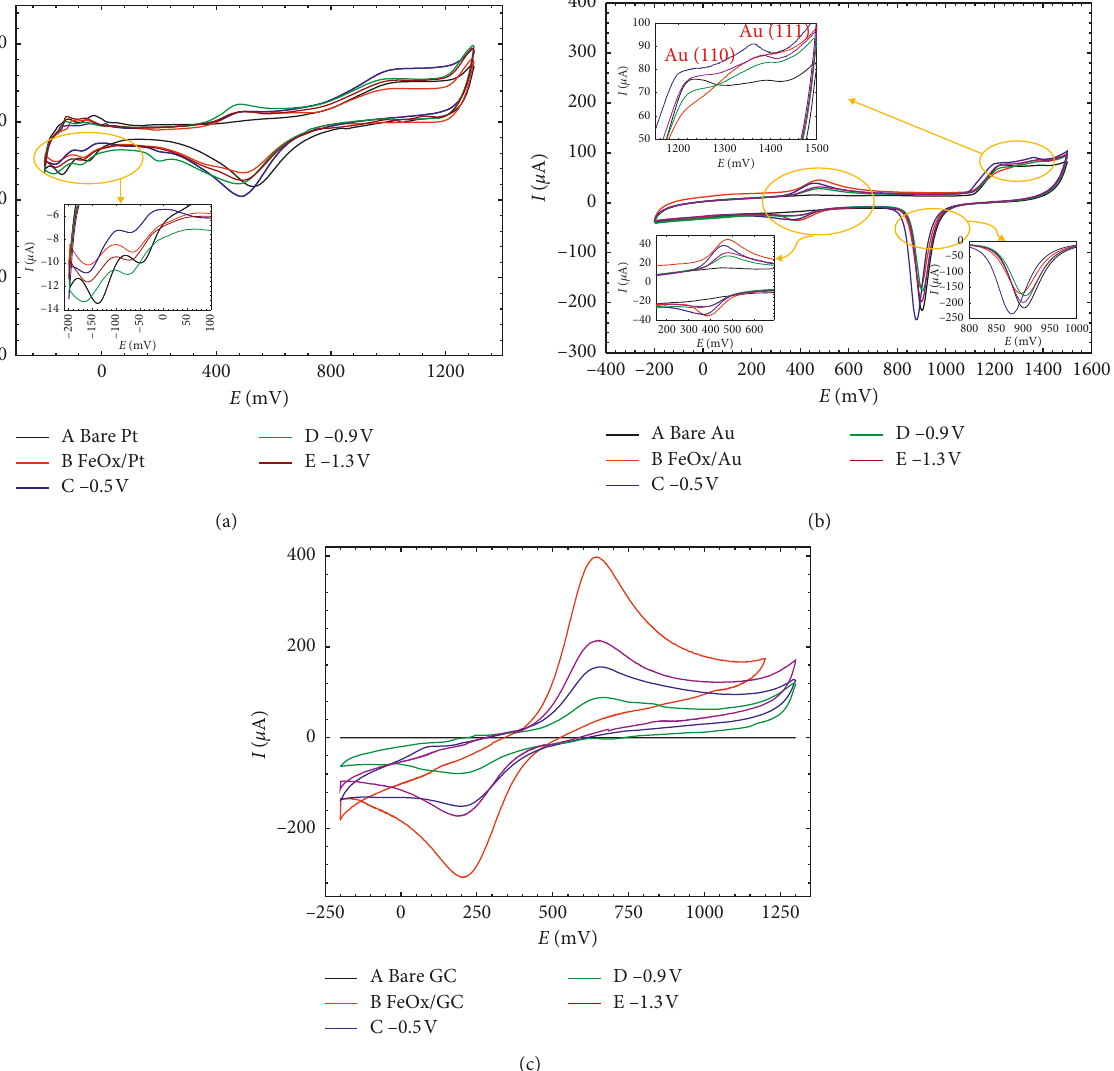
Figure 1: CVs measured in 0.5 M H · s − 1 at bare curve A and nonactivated curve B and activated curve C (at 2 SO 4 at a scan rate 100mV − 0.5V), curve D (at − 0.9 V), and curve E (at − 1.3V) nano-FeOx-modified Pt (a), Au (b), and GC (c) substrates. Activation was pursued for 10min in 0.2mole · L − 1